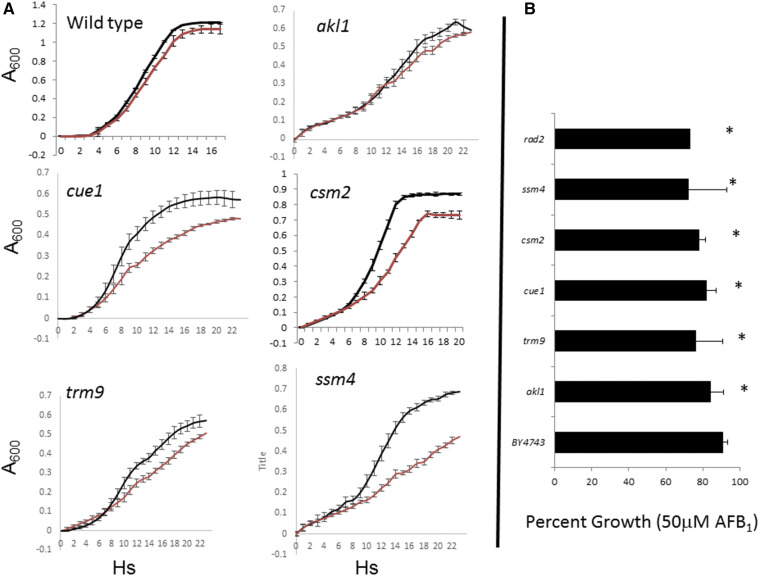
Growth curves for selected diploid mutants identified in the high throughput screen. All strains contain pCS316, expressing CYP1A2. A600 is plotted against time (Hs). Standard deviations are indicated at 1 h time points. The growth curves (Panel A) are indicated for wild type (YB556) and the csm2, alk1, ssm4, cue1, and trm9 diploid mutants. Red lines indicate strains both expressing CYP1A2 and exposed to 50 μM AFB1. The bar graph (Panel B) indicates area percent growth of AFB1-exposed strains as determined by the ratio of the area under curves (area under the curve for treated strain/area under the curve for strain exposed to DMSO x 100%).